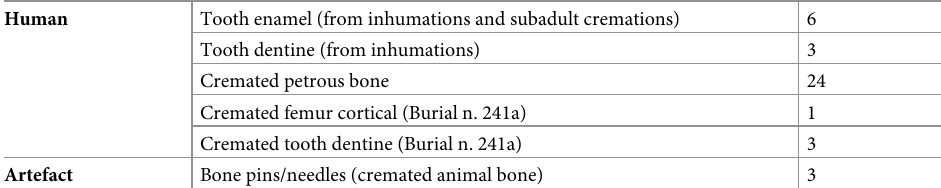
Table 1. Number of analysed specimens for each type of sample.